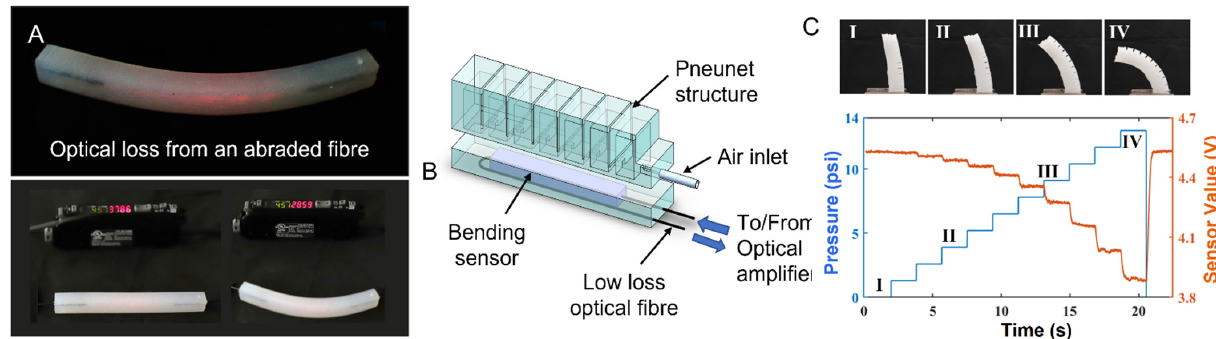
Figure 12. ( A ) Abraded fibre-based bending sensor shows optical loss through the cladding and decrease in light intensity measured by the receiver corresponds to the bending curvature; ( B ) Schematic of a pneumatically controlled soft finger sensorized by the fibre-based sensor; ( C ) (top) the bending shape of the finger under different input pressures and (bottom) the sensor response during the bending process [36].